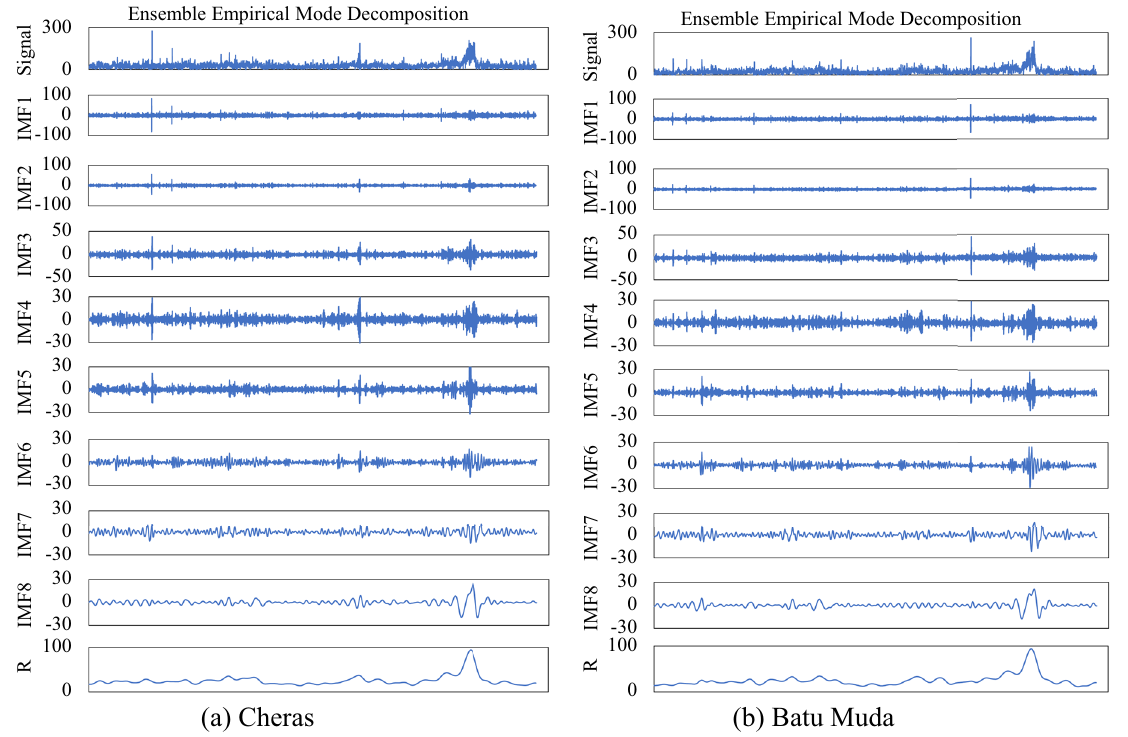
Figure 5. IMFs and residual plot of decomposed concentration data for ( a ) Cheras and ( b ) Batu Muda station.